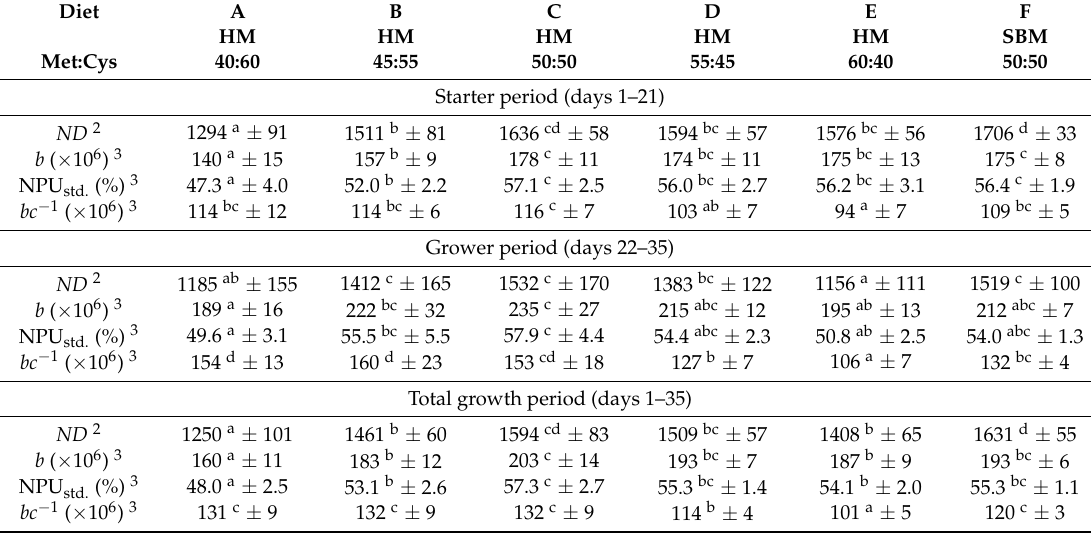
Table 6. Results of dietary protein quality ( b , NPU std. ) and Met efficiency ( bc − 1 ) 1